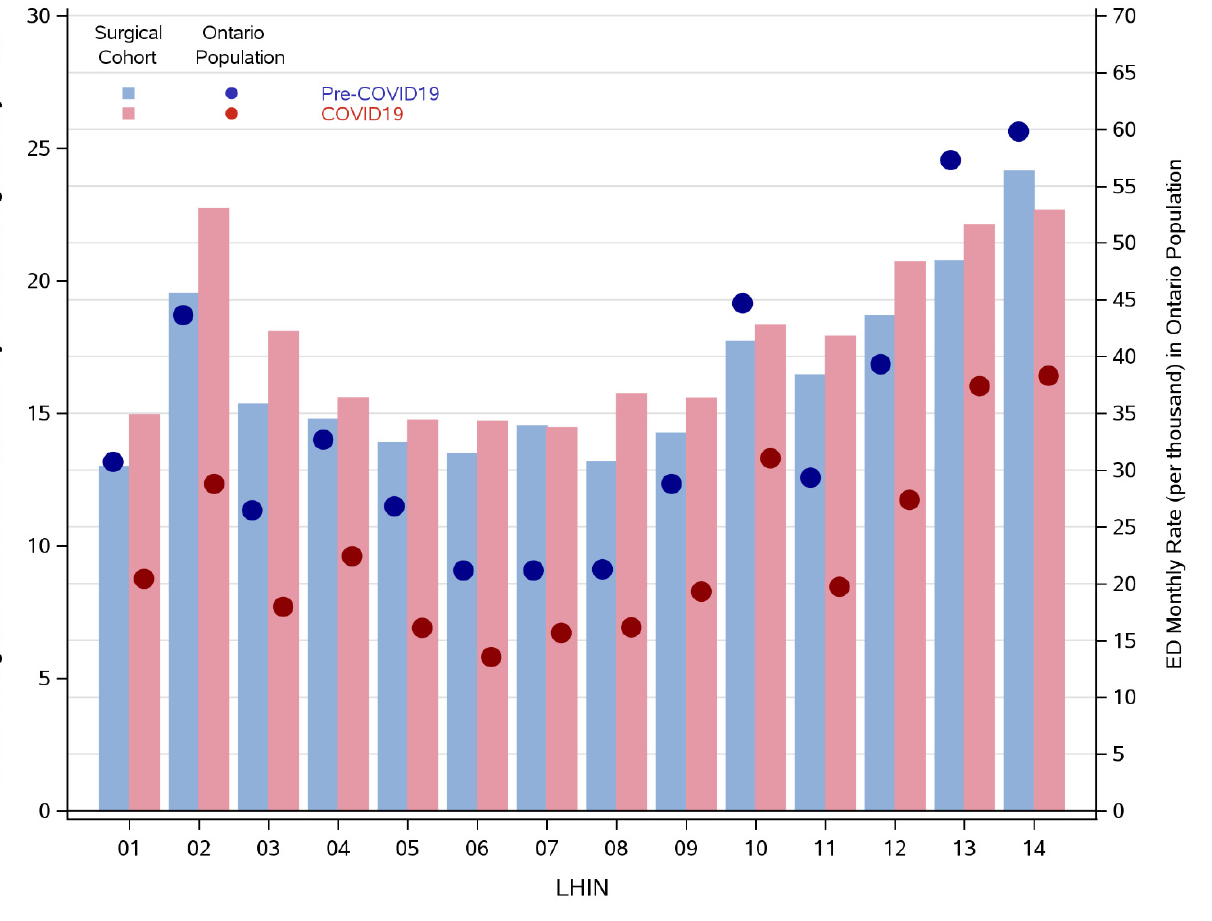
Figure 2. Histogram illustrating ED rates within our cohort of cancer-directed surgeries compared with ED rates in the general provincial population during the pre- and peri-periods, across LHINs. Legend: The y-axis on the left-hand side and corresponding bars reflects the ED rates in our surgical cohort, while the y-axis on the right-hand side and corresponding overlaid points provide the ED rates in the entire province.